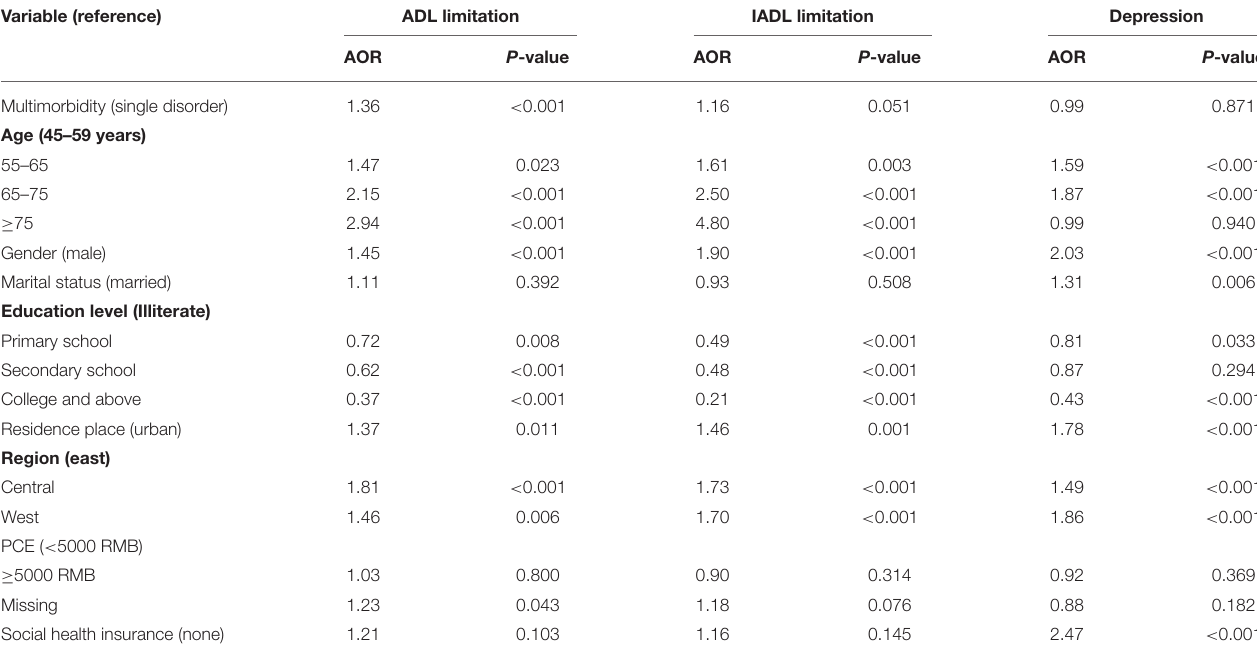
TABLE 4 | The association of metabolic multimorbidity with functional and mental health. Variable